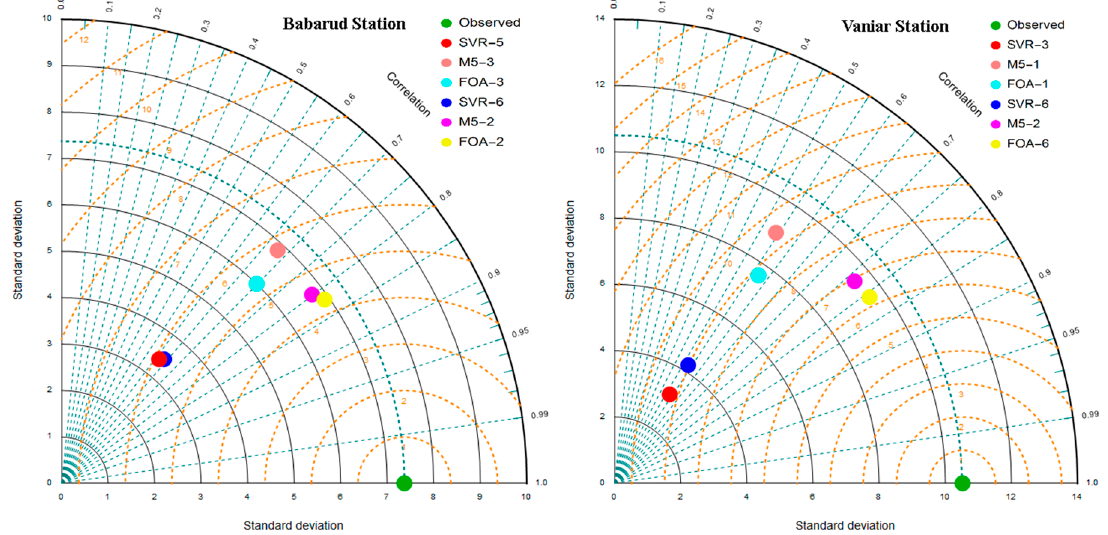
Figure 10. Taylor diagrams (TDs) of the monthly predicted river flow. ( a ) Babarud station, ( b ) Vaniar station.